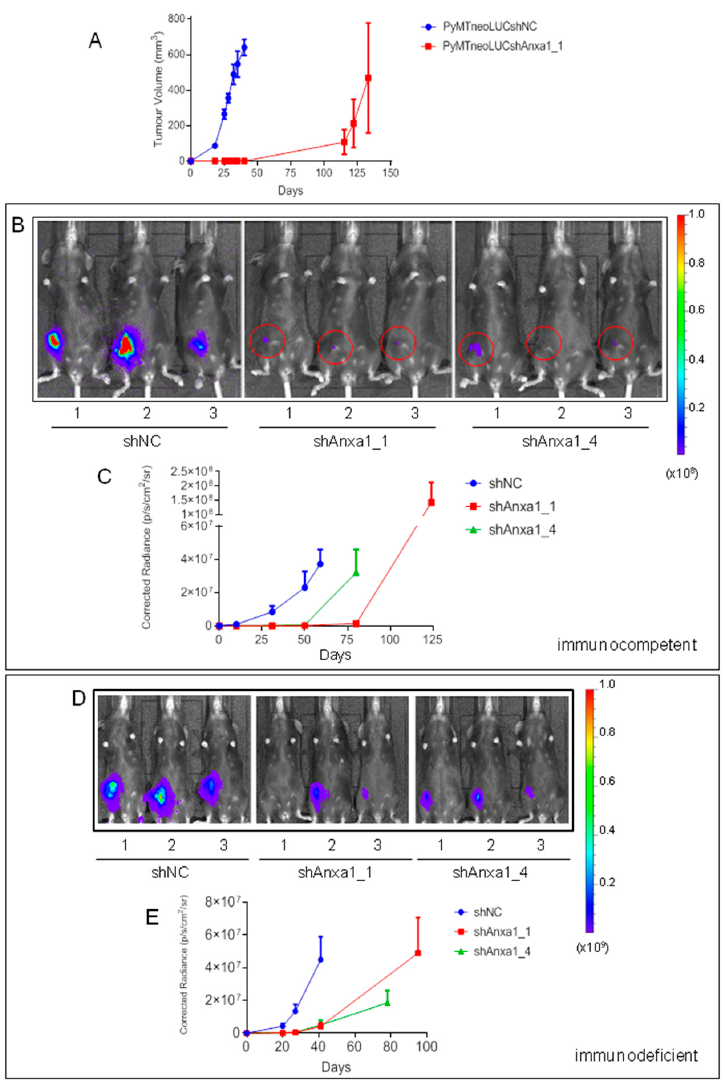
Figure 3. Tumor formation is delayed in both immuno-competent and immuno-deficient C57BL/6 mice with orthotopic transplantation of Annexin-A1-depleted PyMTneoLUC cells. ( A ) Growth rates of orthotopic control PyMTneoLUC_shNC ( n = 7) and PyMTneoLUC_shAnxa1_1 ( n = 5) in C57BL/6 mice were determined by measurement with electronic calipers. Control mice were culled on day 40 and PyMTneoLUC_shAnxa1_1 tumor-bearing mice were culled on day 133. Mean ± SEM. ( B ) Bioluminescent images of C57BL/6 mice bearing the indicated PyMTneoLUC stable transfectants ( n = 3 per group from a total 4 mice per group) on day 31 after inoculation. The color bar on the right indicates radiance (p/sec/cm 2 /sr). Minimum 8 × 10 5 , maximum 1 × 10 8 . ( C ) Quantification of biolu- minescent signals in C57BL/6 mice-bearing PyMTneoLUC_shNC (days 10, 31, 50, 59), PyMTneo- LUC_shAnxa1_1 (days 10, 31, 50, 80, 124), or PyMTneoLUC_shAnxa1_4 (days 10, 31, 50, 80) tumors. The background corrected radiance is plotted versus time. Mean ± SEM. Three mice per group were assessed at each time point ( n = 4 total per group). ( D ) Bioluminescent images (day 41) of